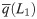
QDT prediction (quarter law).Predicted (theoretical) appearance of the choice probability of the risky prospect, pth(L1), for a positive (blue, dotted line) or negative (red, dashed line) attraction factor q¯(L1) of absolute value equal, on average, to 0.25, and sketch of empirical probability, pemp(L1) (green, dot-dash line).